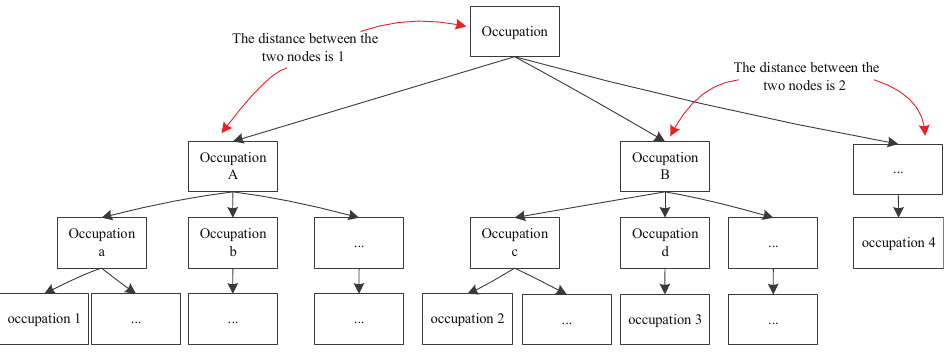
Figure 4. Occupational classification